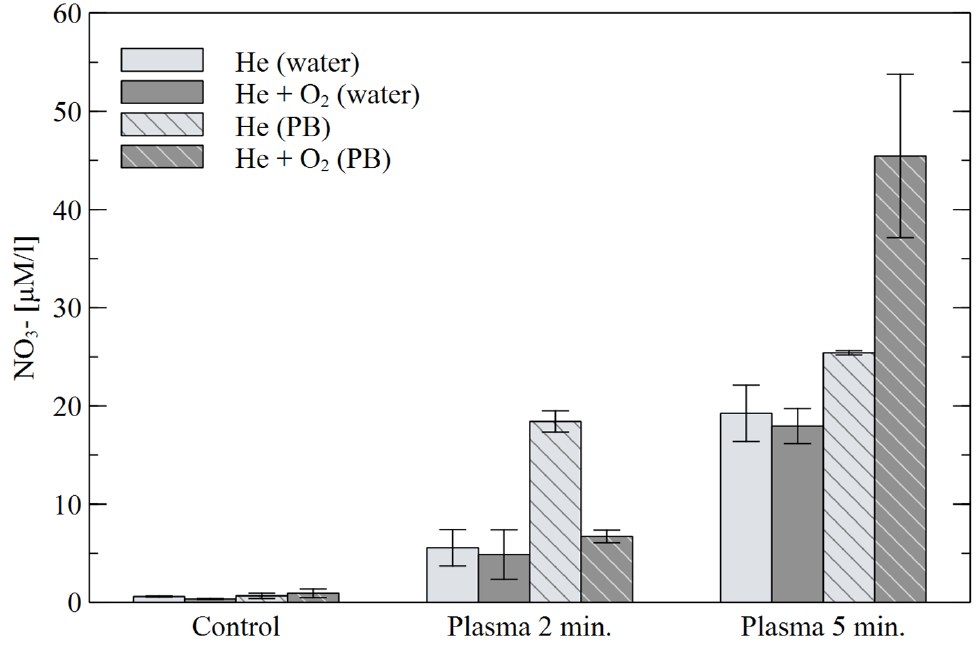
Figure 10. Concentration of NO 3 − in water and PB for different treatment times.